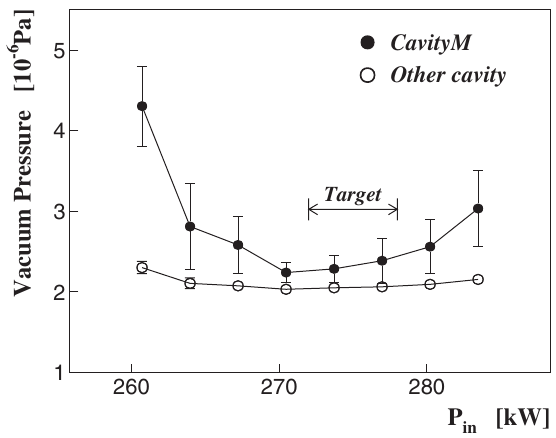
FIG. 7. Vacuum pressures in CavityM and in the other cavity which has no multipactoring problem. Each point is an average of about ten measurements, and the vertical bars indicate a statistical error. The horizontal arrow denotes the target power region for the beam loading